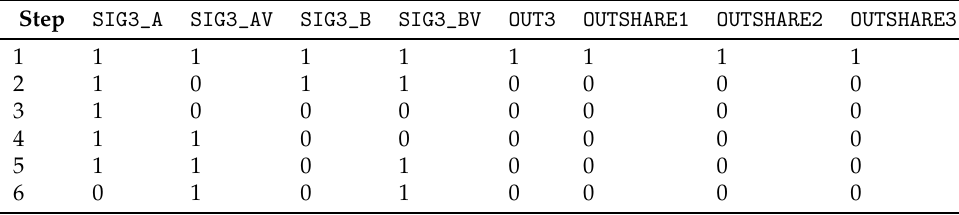
Table 5. Test Case 3—Derailment